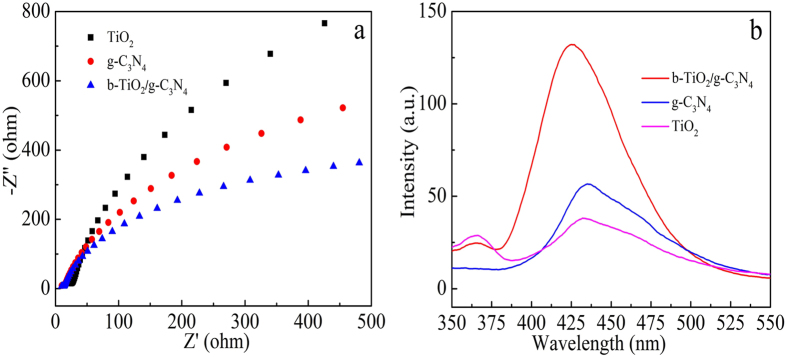
Electrochemical impedance spectra (a) and fluorescence intensity in 1 h (b) of TiO2, g-C3N4 and b-TiO2/g-C3N4, respectively.